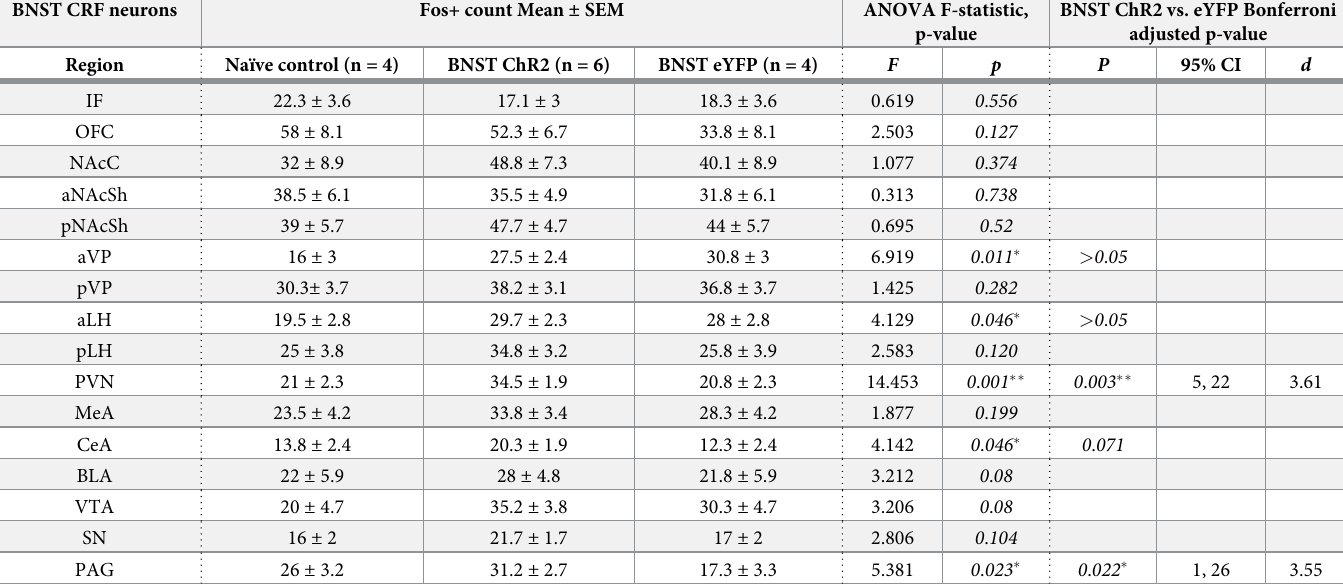
Table shows Fos+ protein quantification in mesocorticolimbic regions after final exposure to ChR2 excitation in BNST (n = 3 female, n = 3 male ChR2 group). Fos + protein quantification in mesocorticolimbic regions (left columns) for na ï ve unoperated control rats, ChR2 rats, and eYFP rats, were compared with a one-way ANOVA for each structure targeted. “Fos+ Count” reflects mean of each group at each site ± standard error (SEM). Follow up two-tailed t-tests with Bonferonni corrections were performed between ChR2, eYFP, and naiive control groups. The right column includes p- values, confidence intervals, and effect sizes for instances where ChR2 rats were found to significantly differ from eYFP controls. Percent change in ChR2 rats from eYFP controls are depicted in Fig 3. IF, infralimbic cortex; OFC, orbitofrontal cortex; aNAcSh, anterior nucleus accumbens shell; pNAcSh, posterior nucleus accumbens shell; NAcC, nucleus accumbens core; aVP, anterior ventral pallidum; pVP, posterior ventral pallidum; aBNST, anterior bed nucleus of stria terminalis; pBNST, posterior bed nucleus of stria terminalis; aLH, anterior lateral hypothalamus; pLH, posterior lateral hypothalamus; PVN, hypothalamic paraventricular nucleus; MeA, medial amygdala; CeA, central amygdala; BLA, basolateral amygdala; VTA, ventral tegmentum; SN, substantia nigra; PAG, midbrain periaqueductal gray. � p < 0.05, �� p < 0.01, ��� p <